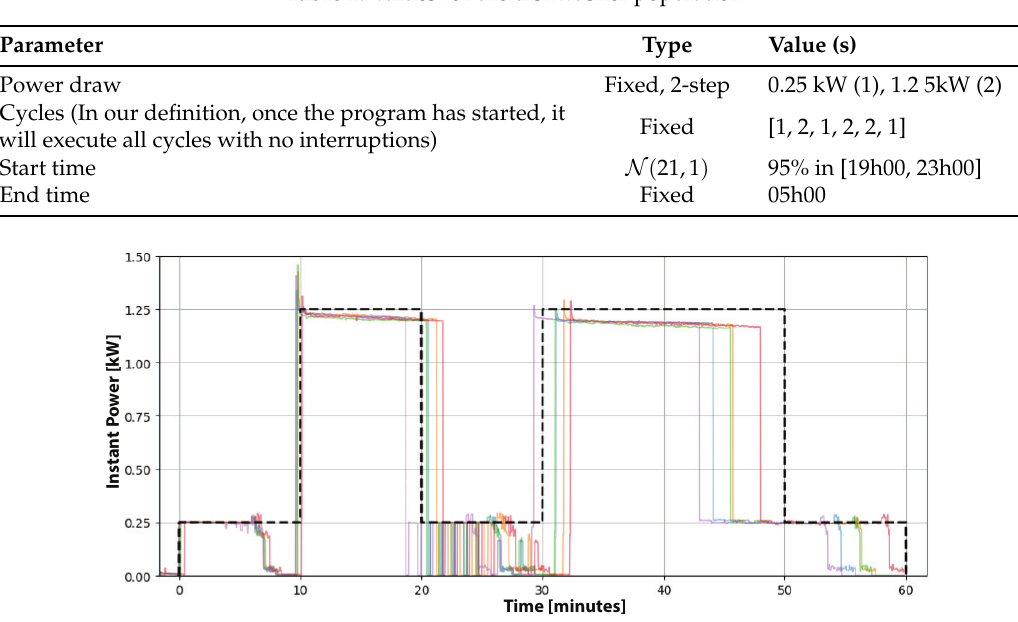
Figure 3. Overlapped dishwasher cycles (thin lines), and approximate power profile (dashed thick line).